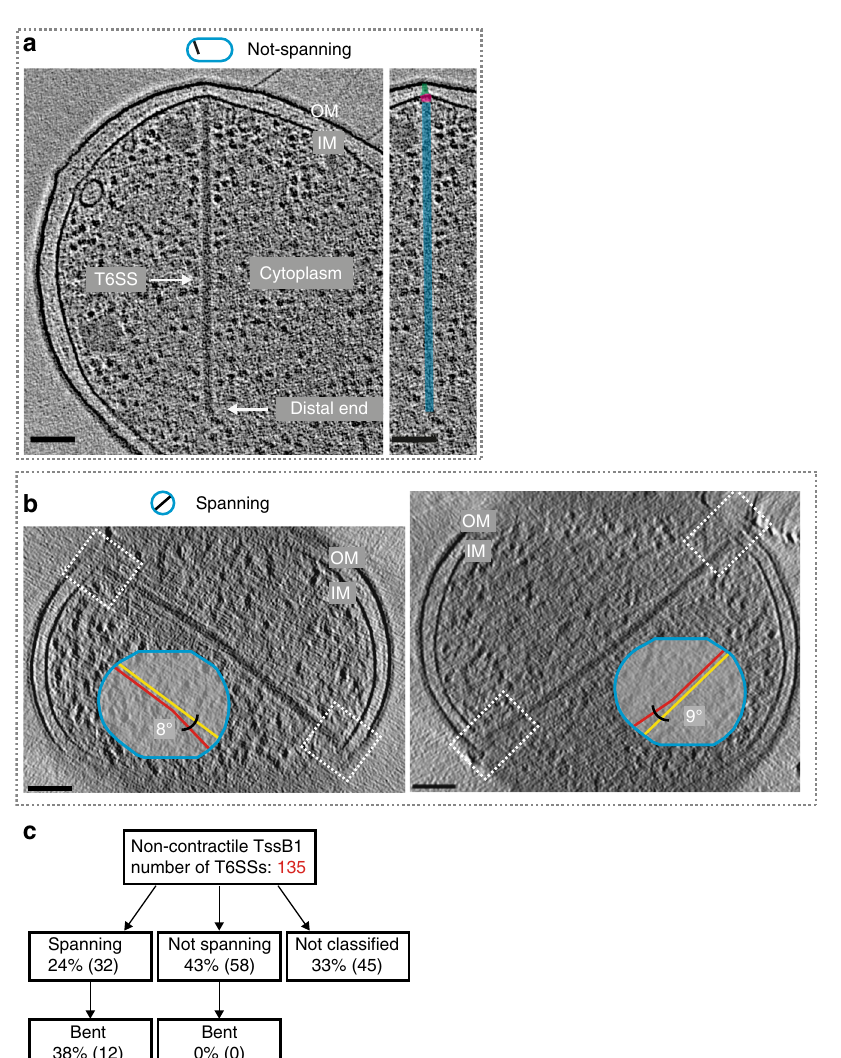
Fig. 2 ECT imaging of a non-contractile TssB1 mutant reveals T6SS structures that span the cells and are bent. Shown are tomographic slices (21.6 nm thickness) of three examples of EAEC T6SSs (non-contractile TssB1 mutant) imaged by ECT. Schematics above indicate the viewing angle and approximate orientation of the T6SS in the cell. IM, inner membrane; OM, outer membrane. Scale bars: 100 nm. a One class of structures was found with the proximal end attached to the cell envelope and with the distal end ending in the cytoplasm (left panel). The structural modules transenvelope complex (green)/ baseplate (magenta)/sheath-tube (cyan) were segmented in the right panel. b A second class of T6SSs spanned across the cytoplasm and both ends were associated with opposing membranes. Shown are cross sections (views along the cell ’ s long axis) of two examples. Spanning T6SSs were frequently bent >5° (illustrated by the schematic insets). White dashed rectangles highlight the areas where the T6SS ends approach the cell envelope. Note that for any given structure, it was impossible to distinguish the proximal and distal ends with high con fi dence. c Diagram quantifying the classi fi cation of imaged T6SSs. Note that bending (bending angle de fi ned as >5°) was only observed for spanning structures. T6SSs for which the missing wedge prevented from reliable classi fi cation were categorized as “ not classi fi ed ” (see Supplementary Fig.